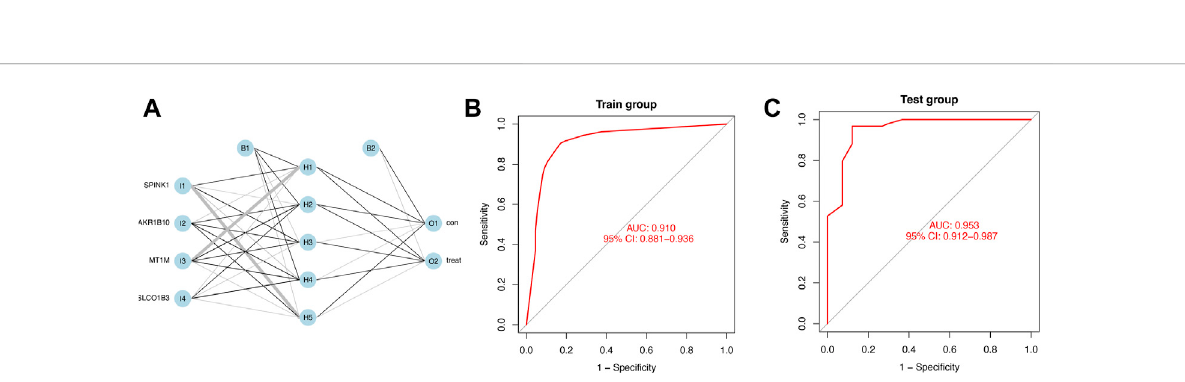
FIGURE 5 Diagnostic model constructed by the ANN (A) Schematic representation of the ANN model developed to predict the risk of HCC and normal samples. Thin lines represented synaptic weight < 0; the thicker lines represented synaptic weight > 0. (B) AUC of ROC curves veri fi ed the diagnostic performance of the ANN model in the training cohort. (C) AUC of ROC curves veri fi ed the diagnostic performance of the ANN model in the testing